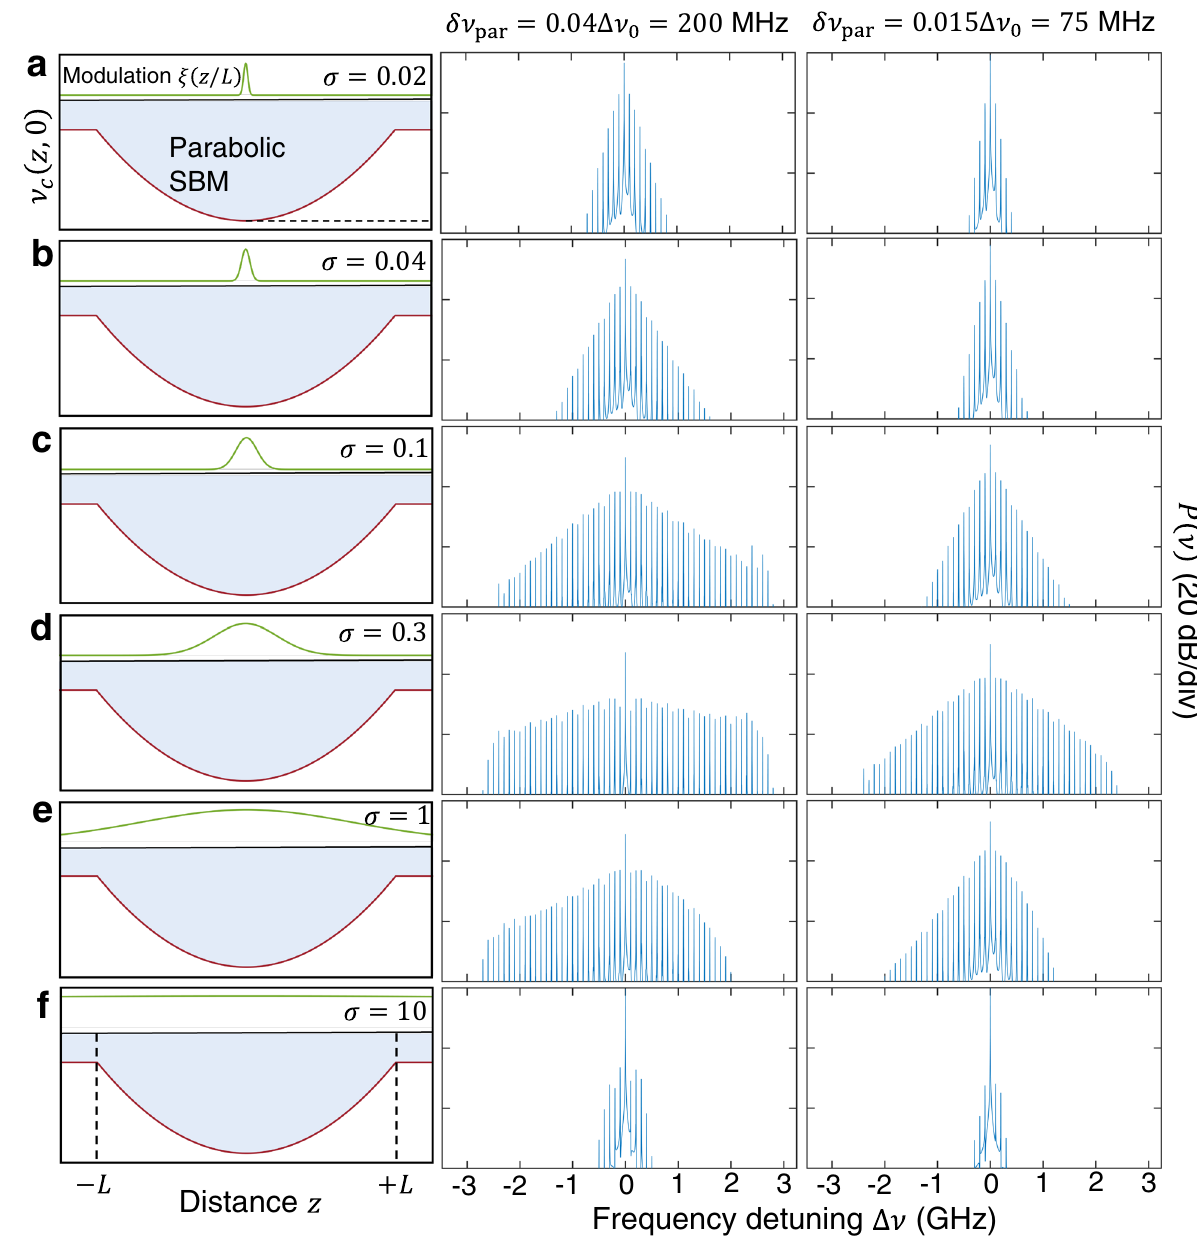
Fig. 5 Optical frequency combs (OFCs) generated with a Gaussian spatial distribution of the modulations (SDPMs) in the resonant regime. The (cid:1) (cid:3) ¼ e (cid:4) z = σ L ð Þ 2 (green line) for two maximum modulation parabolic SNAP bottle microresonator (SBM) (red line) is modulated with a Gaussian SDPM ξ z = L amplitudes, δ ν par ¼ 200 MHz and δ ν par ¼ 75 MHz, and for different values of σ . a A strongly localised modulation ( σ ¼ 0 : 02) leads to the formation of a narrow bandwidth OFC spectrum with a few comb resonances. b , c The bandwidth of the frequency comb spectrum increases with the width σ of the SDPMs. d The optimal spectrum with largest bandwidth is achieved at σ (cid:6) 0 : 3. e The bandwidth of the OFC starts to decrease when the value of σ is (cid:1) (cid:3) (cid:1) (cid:3) 2 for σ ¼ 1. f The generation of combs is strongly ¼ e (cid:4) z = σ L ð Þ 2 (cid:8) z = L further increased. This case corresponds to a parabolic SDPM since ξ z = L suppressed in the case of a uniform (cid:1) (cid:3) ¼ e (cid:4) z = σ L ð Þ 2 with dimen- Gaussian SDPM determined by ξ z = L sionless widths σ varying from 0.02 to 10. We consider two ¼ 2 nm, as in the adiabatic case. The ¼ 200 MHz and the SBM considered is Δ r modulation amplitude maxima, δ ν par ¼ 0 : 04 Δ ν 0 0 attenuation factor and coupling coef fi cient are set to γ ¼ 2 π MHz ¼ 75 MHz, which are much smaller than the δ ν ¼ 0 : 015 Δ ν par 0 ¼ 0 : 001 1 þ i ð Þ μ m (cid:4) 1 . The corresponding Q-factor of and D 0 . From the scaling relation maximum CFV of the SBM Δ ν ¼ 3 ´ 10 7 . 0 calculated from Eqs. (5) and (6) is Q mode q δ r ¼ r δ ν = ν , these amplitudes correspond to the ERV q 0 0 par par 0 c 0 The results of our numerical modelling of Eq. (3) are shown in δ r ¼ 80 pm and δ r ¼ 30 pm, respectively. Contrary to the par par Fig. 5. As in the adiabatic case, the OFCs are generated by the